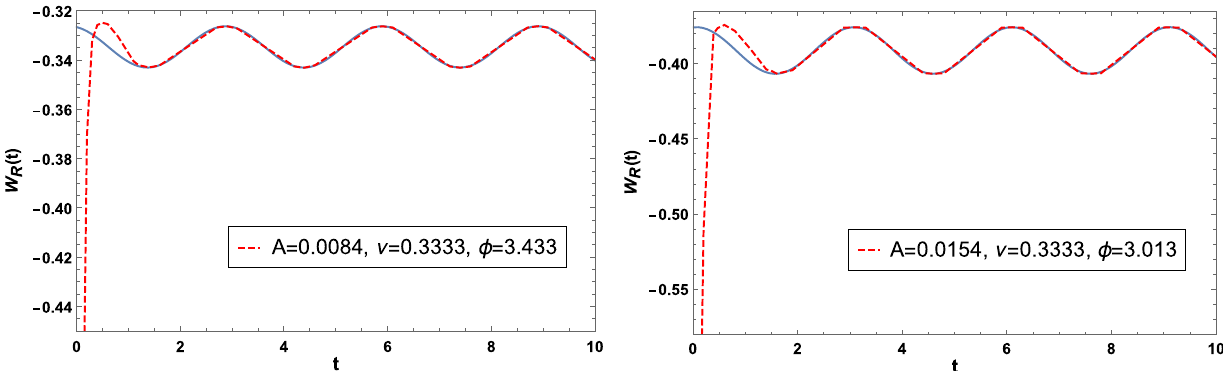
for left (right) graph. The dashed red curve shows our numerical results and the blue sine curve is the fitted function (26)